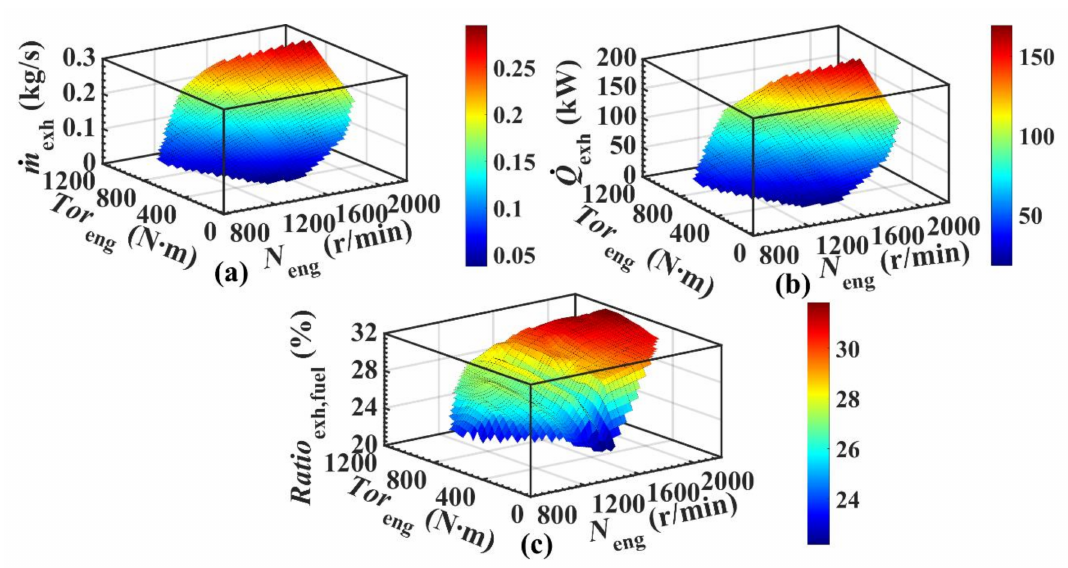
Figure 2. Dynamic characteristics of exhaust waste heat under full operating conditions. ( a ) exhaust mass flow rate distribution characteristics under full operating conditions. ( b ) exhaust heat transfer rate distribution characteristics. ( c ) proportion of exhaust heat transfer rate to the energy released by fuel